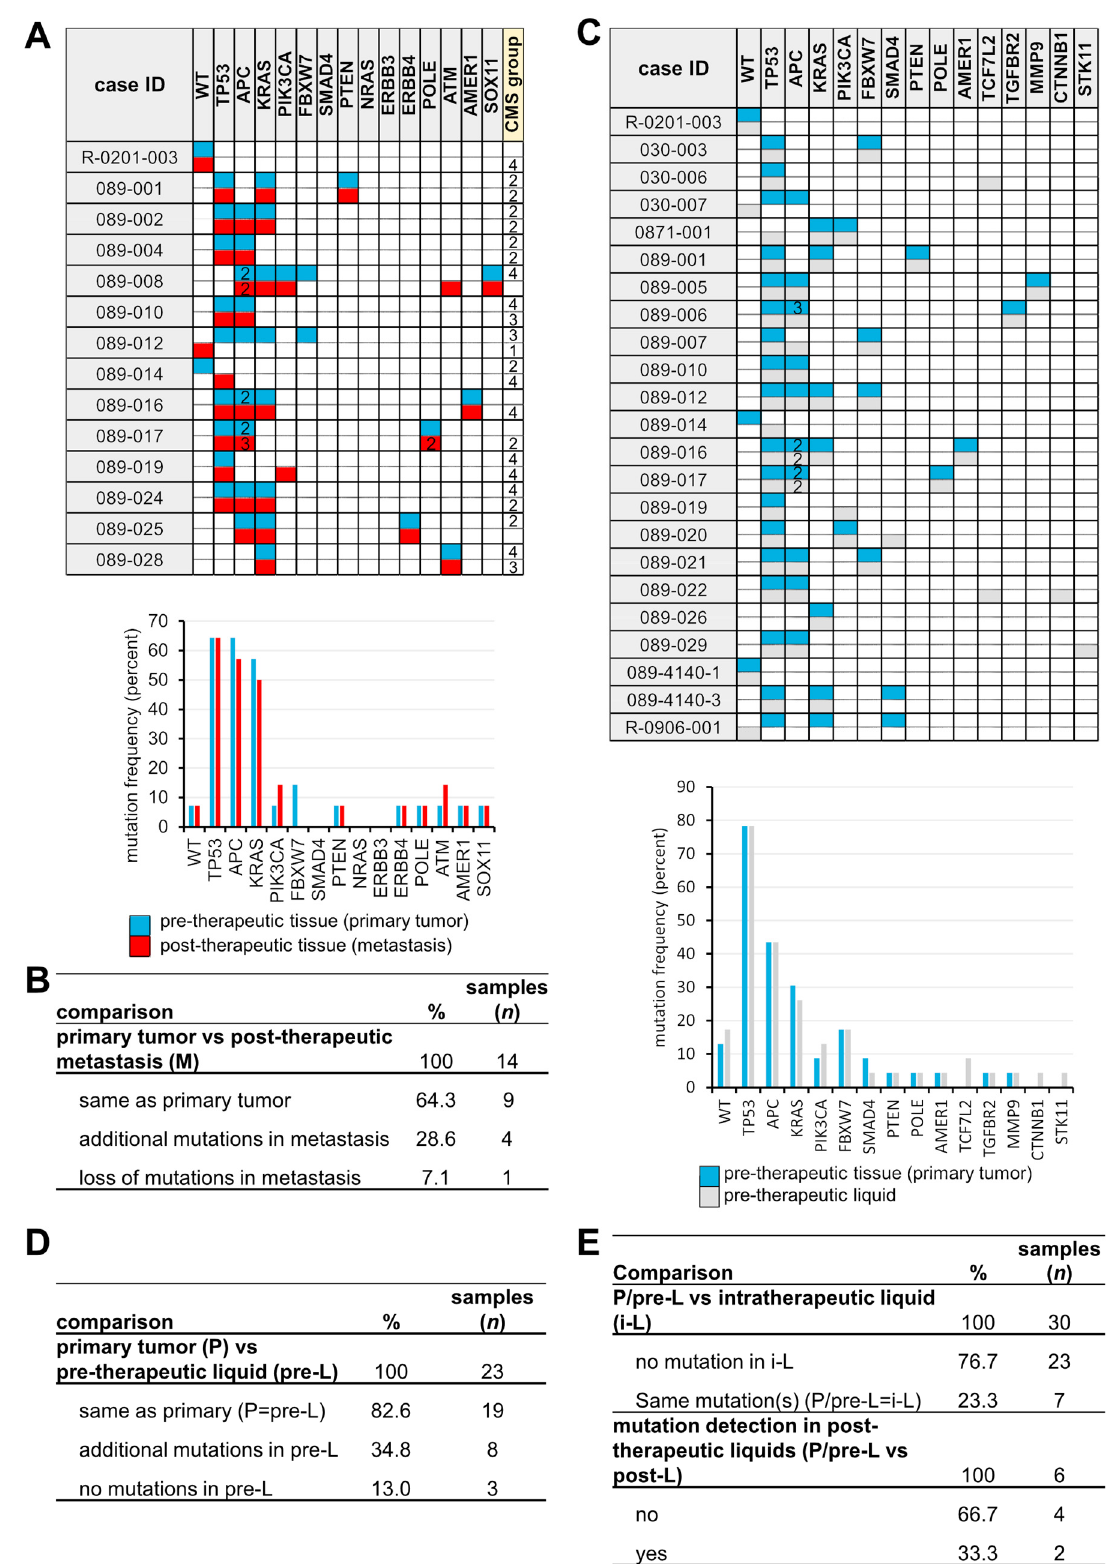
Figure 2. Pre-, intra-, and post-therapeutic mutational screening. ( A ) Mutations and frequencies (%) in matched P and M ( n = 14). ( B ) Comparison of P vs. M. ( C ) Mutations and frequencies in matched P and pre-L ( n = 30). ( D ) Comparison of P vs. pre-L. ( E ) Comparison of P/pre-L vs. i-L and P/pre-L vs. post-L.